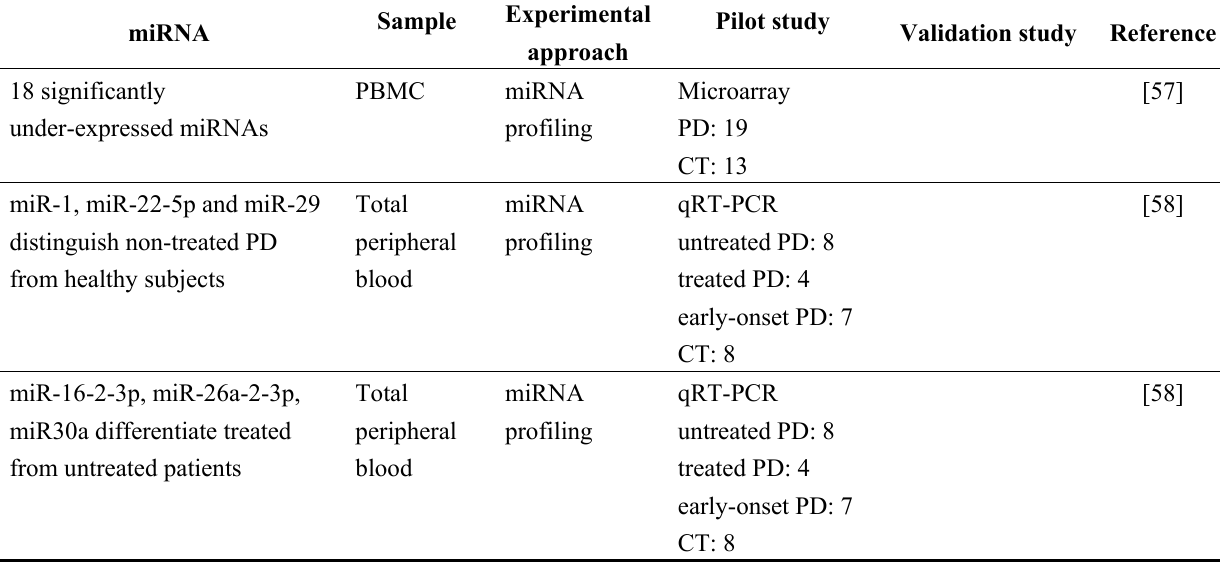
Table 2. Parkinson’s Disease and circulating